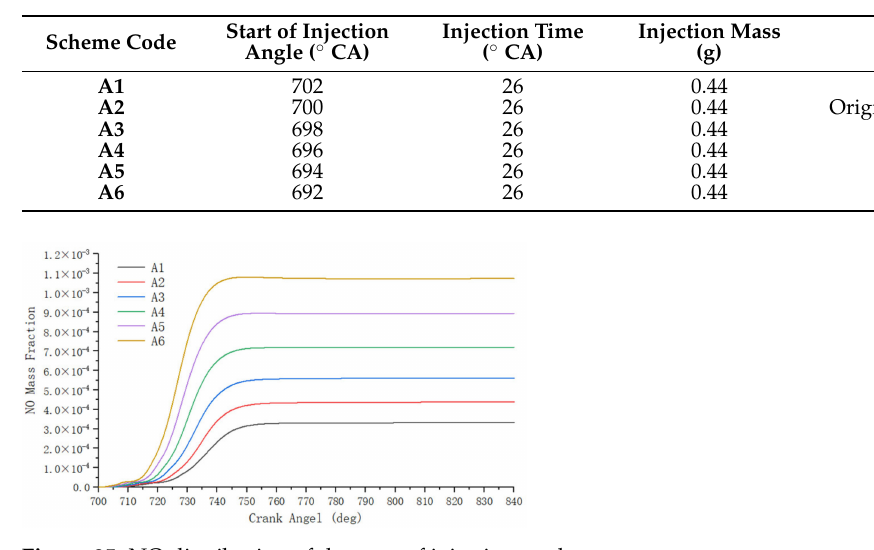
Figure 35. NO distribution of the start of injection angle.